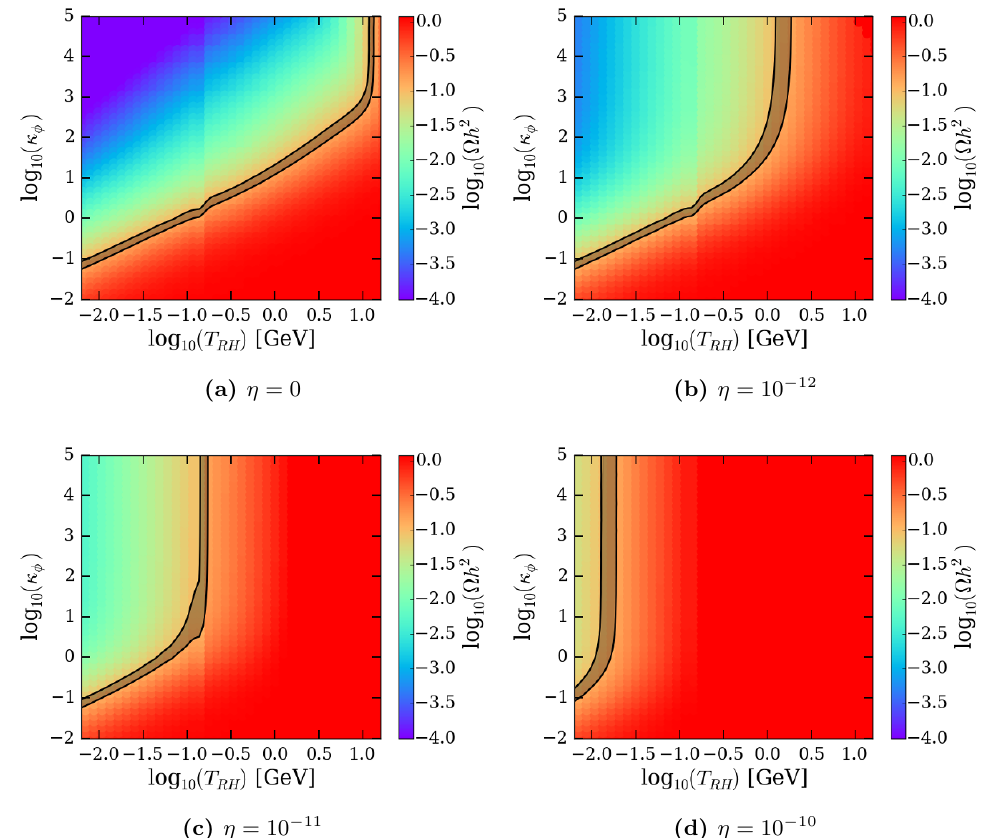
Figure 4. The e(cid:11)ect of varying (cid:17) on log